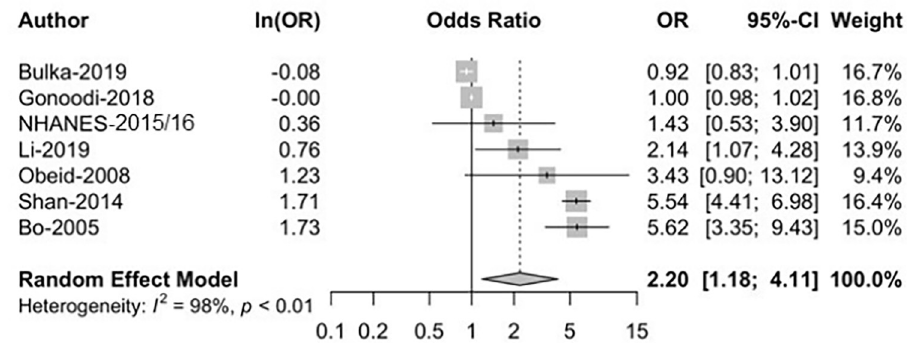
Fig 3. Meta-analysis of the association between zinc deficiency and high fasting plasma